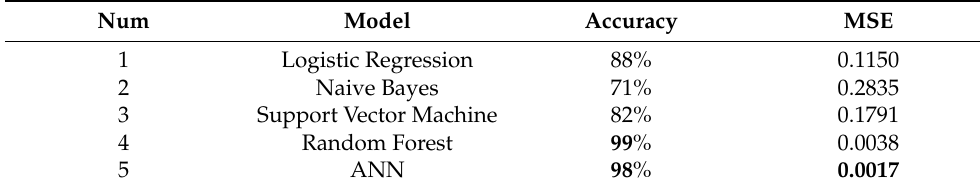
Table 3. Machine Learning Classifiers.